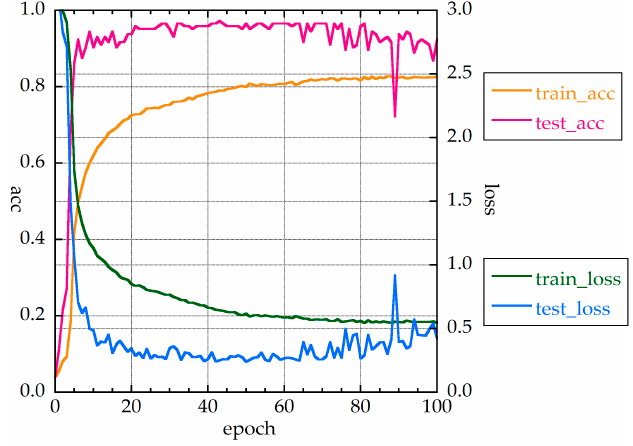
Figure 15. Accuracies and loss function values of CNN1d_HQ.